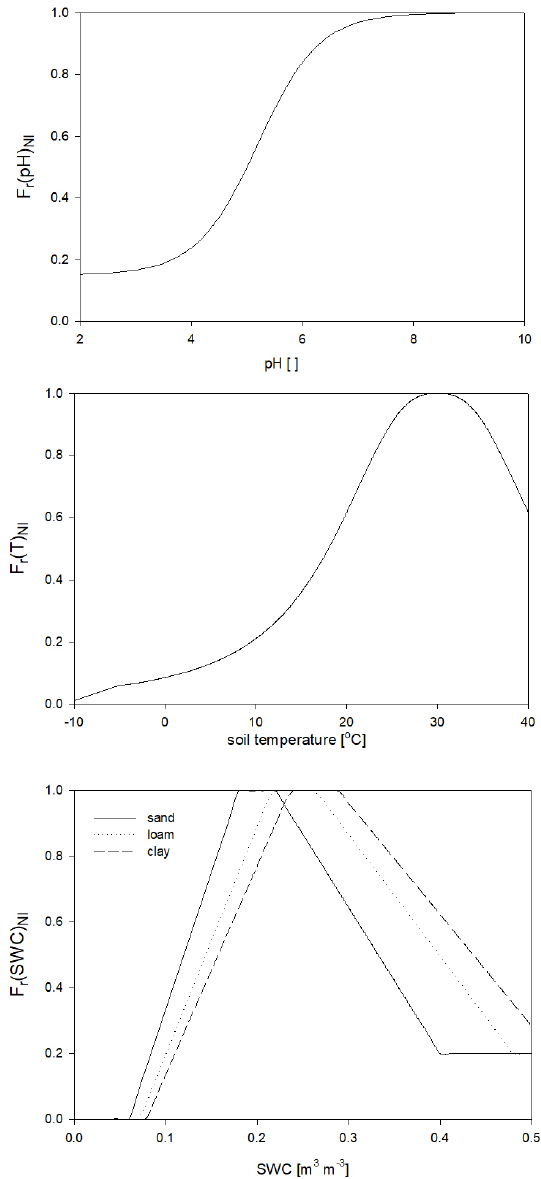
Figure 6. The dependence of the individual factors of the environ- mental response function of nitrification on soil pH ( F r ( pH ) NI ), temperature ( F r (T ) NI ), and SWC F r ( SWC ) NI in the case of dif- ferent soil types. The pH and temperature response functions are independent of the soil